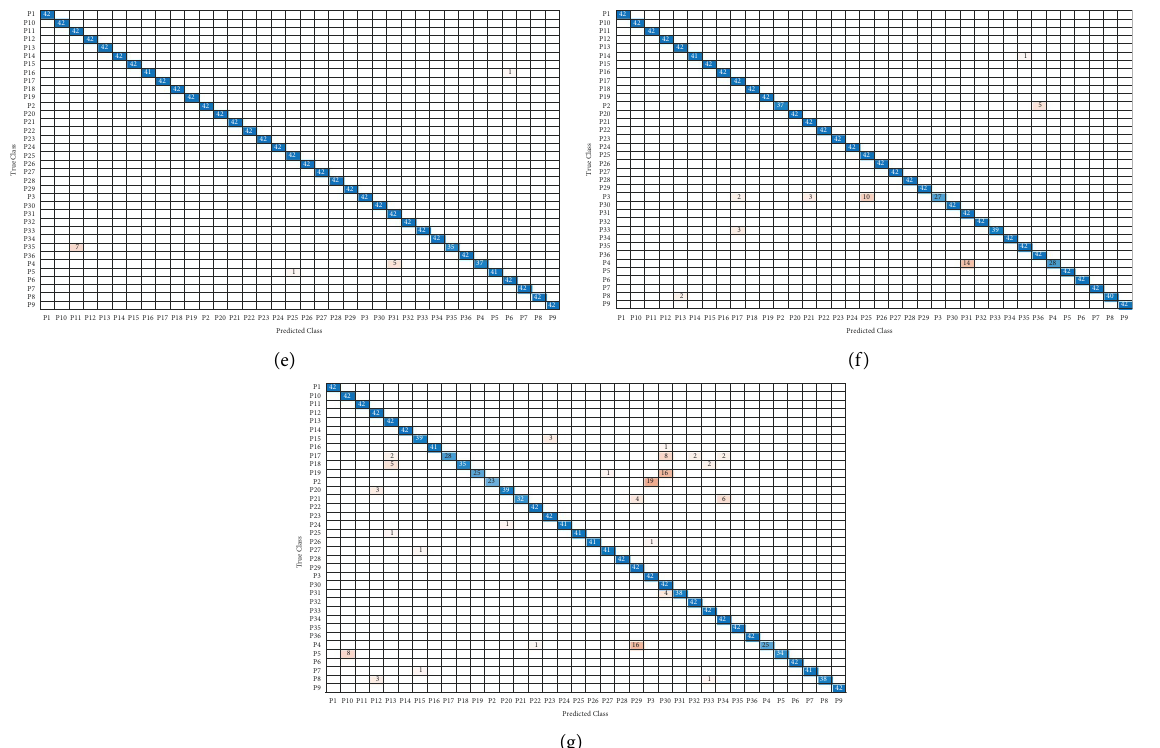
Figure 10: Te confusion matrix result of the main dataset for seven pretrained models. (a) Alexnet, (b) VGG16, (c) ResNet50, (d) NasNetMobile, (e) Inceptionv3, (f) Xception, and (g)